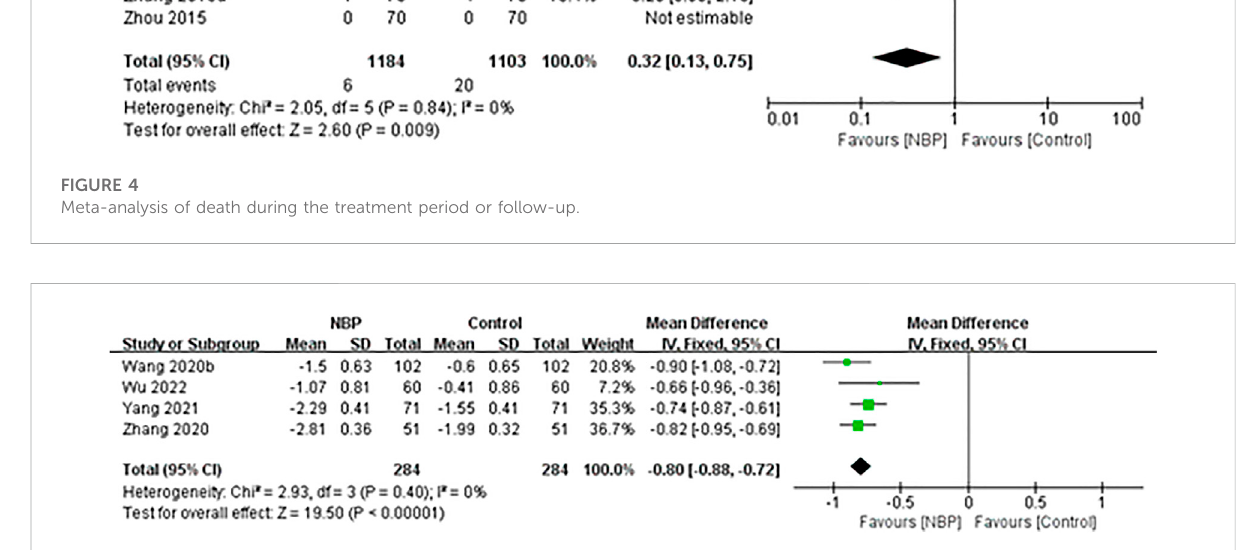
FIGURE 5 Meta-analysis of the modi fi ed Rankin Scale after treatment, as an index of functional